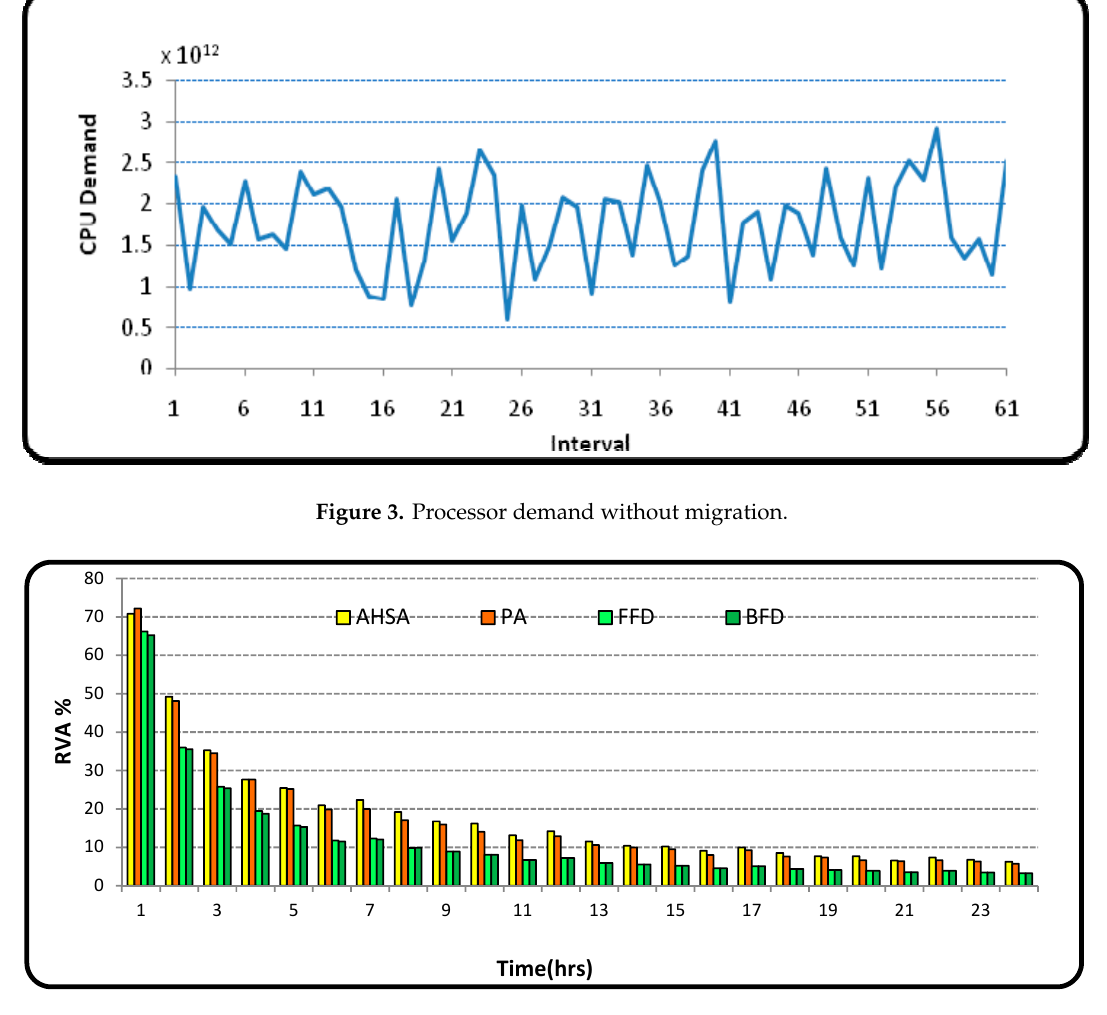
Figure 5. RVA% Scenario I within an hour.